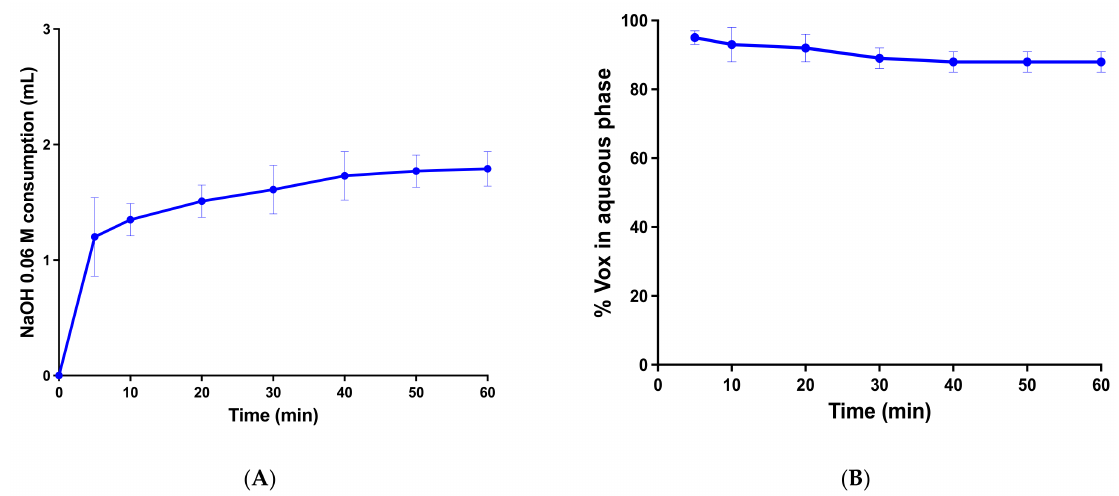
Figure 7. ( A ) NaOH consumption of SNEDDS during in vitro lipolysis. Data are expressed as the mean ± SD, n = 3. ( B ) VOX content in the aqueous phase during in vitro lipolysis. Data are expressed as the mean ± SD, n = 3.